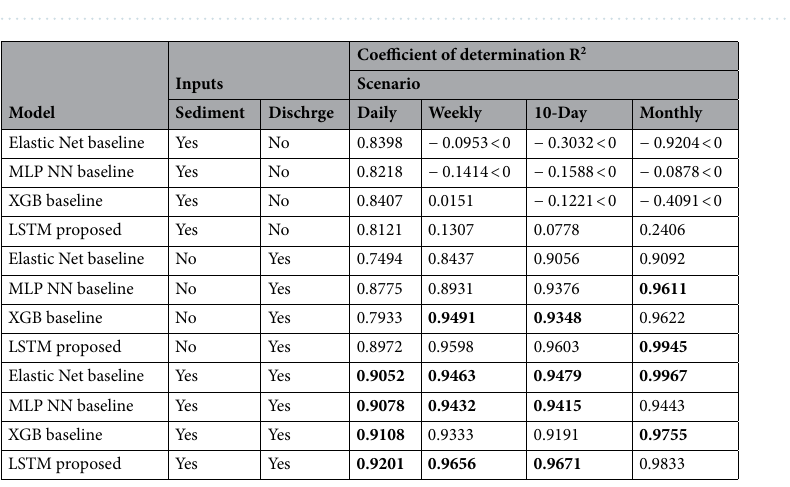
Figure 11. Learning curves for LSTM in weekly (on the right) and monthly (on the left) scenarios.